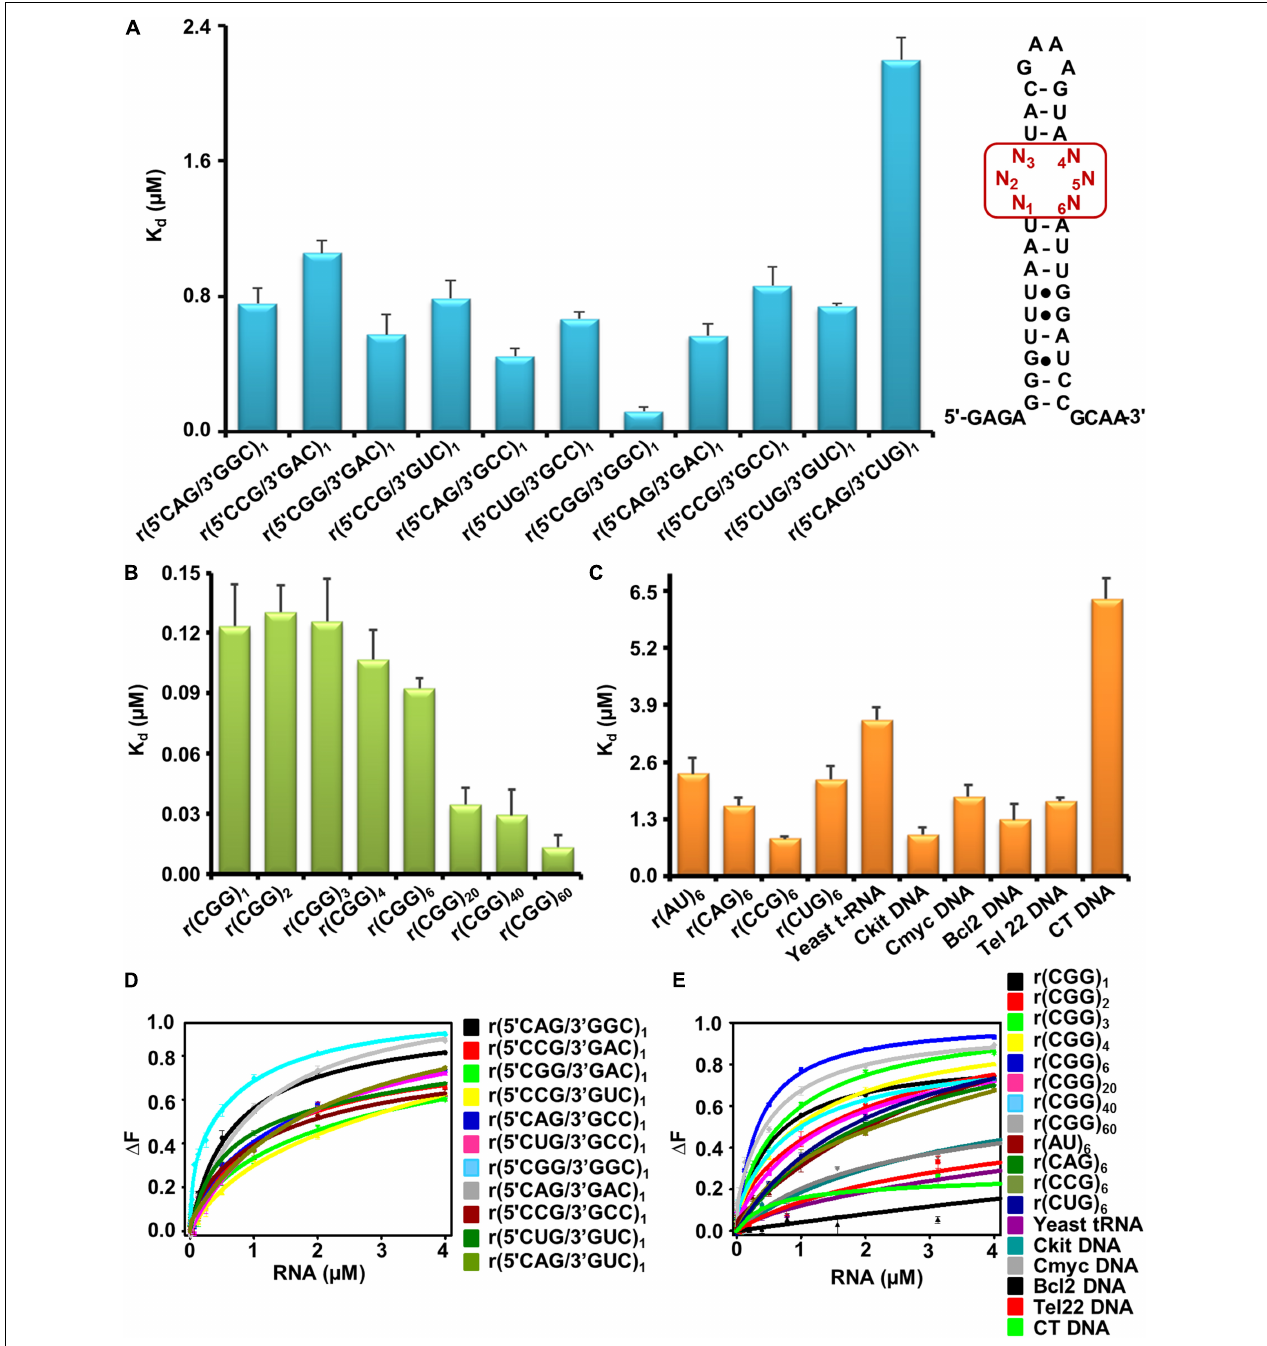
FIGURE 1 | Elucidation of binding affinity (K d ) of Curcumin with nucleic acids using fluorescence based assay. (A) Bar graph representing the binding constant (K d ) values of Curcumin with different 1 × 1 nucleotide internal motif RNAs. (B) Bar graph showing binding affinities (K d ) of Curcumin with different expanded CGG RNAs. (C) Bar chart showing K d values of Curcumin with various RNA and DNA controls. (D) Plot illustrates curves fitting for fluorescence binding assay of Curcumin with different 1 × 1 nucleotide internal loop RNAs. (E) Plot illustrates curves fitting for fluorescence binding assay of Curcumin with different CGG repeat containing RNAs along with different RNA and DNA controls. The Curve was fitted using two mode binding